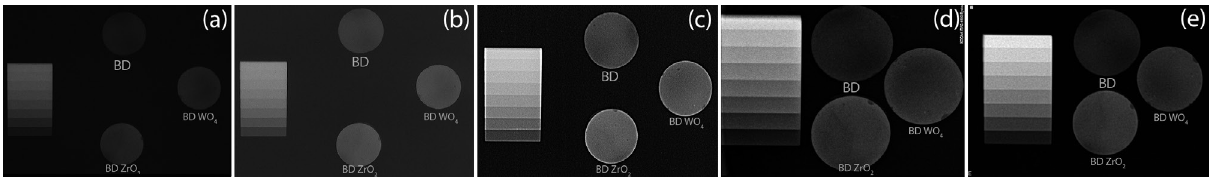
Different letters in the columns indicate statistically significant differences between radiographic systems (P<0.05)